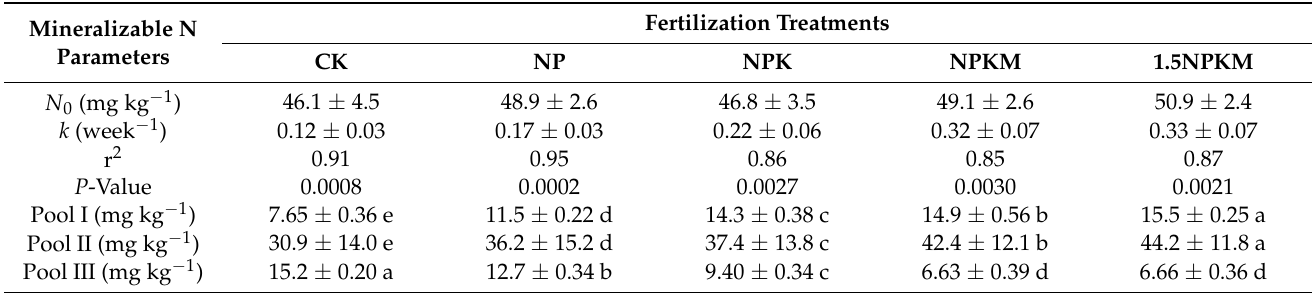
Table 2. Nitrogen mineralization potential N ( N 0 ), mineralization rate constant ( k ), and mineralizable N pools after 26 years of fertilization.